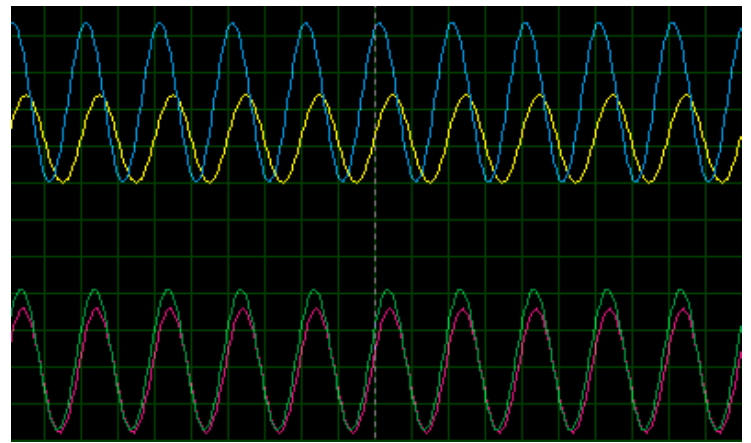
Figure 9. The isolation performance of the LNA simulated at 25 MHz. Top waveforms are at 0.2 V per division; bottom waveforms are at 0.5 V per division.